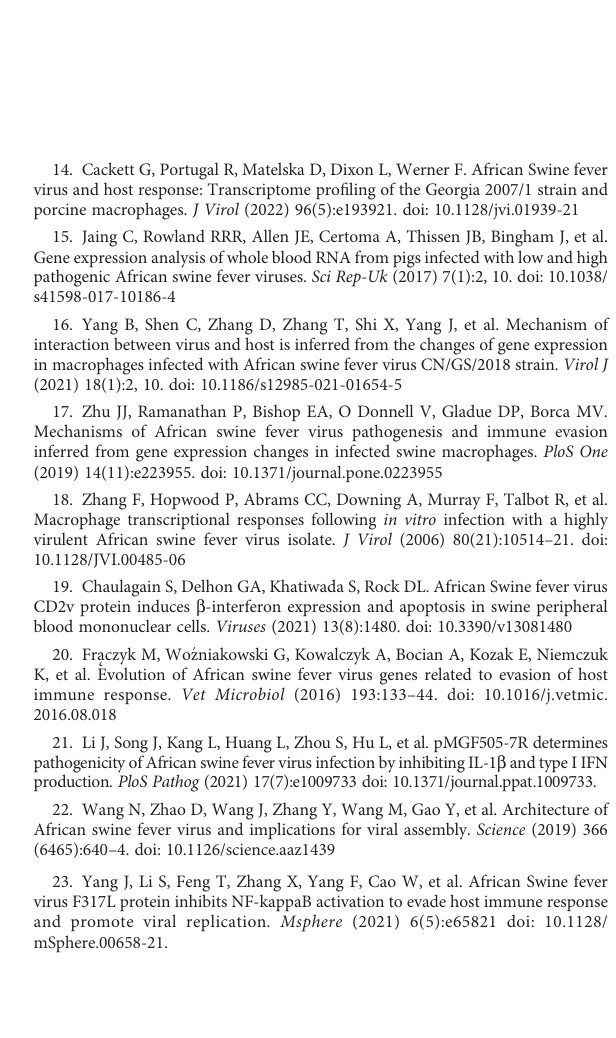
SUPPLEMENTARY TABLE 3 Host gene promoter motif. SUPPLEMENTARY TABLE 4 GO BP enrichment of host DEGs with time series. SUPPLEMENTARY TABLE 5 Host DEGs involved in NF-kB related pathways. SUPPLEMENTARY TABLE 6 Classi fi cation of DEGs between two strains across time points. SUPPLEMENTARY TABLE 7 GO BP enrichment of DEGs in clusters I and II between the two strainsacross time points. SUPPLEMENTARY TABLE 8 Pearson correlation between viral DEGs and host DEGs. SUPPLEMENTARY TABLE 9 Primers for real time-PCR